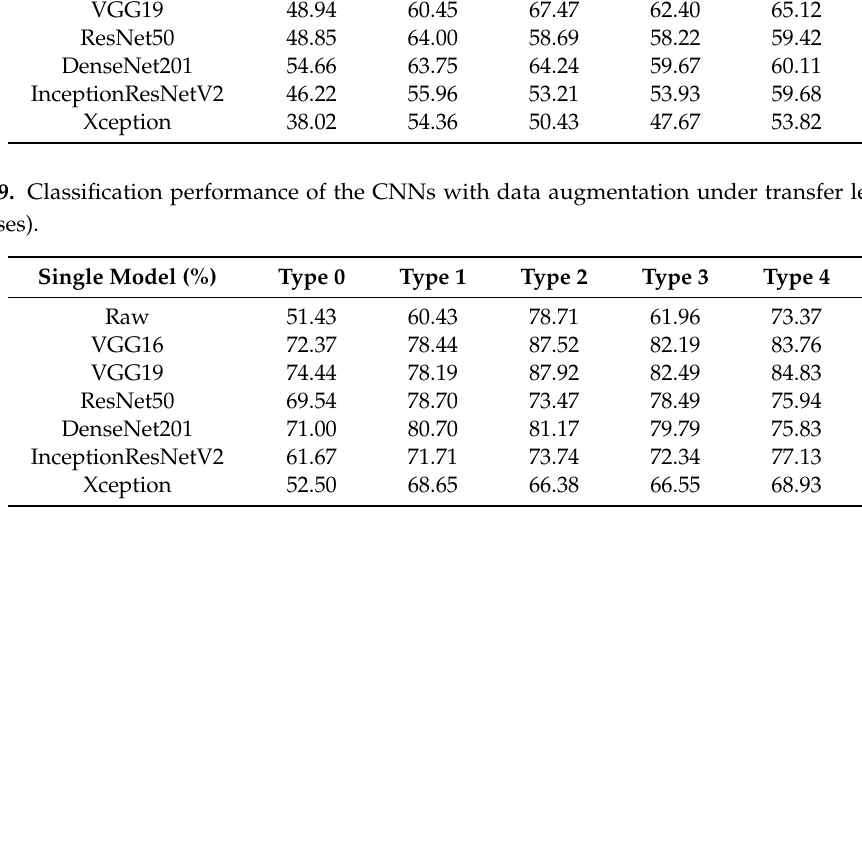
Figure 18. Confusion matrix for VGG19 with preprocessing of type 2. Table 8. Classification performance of the CNNs with data augmentation under transfer learning (10 classes).